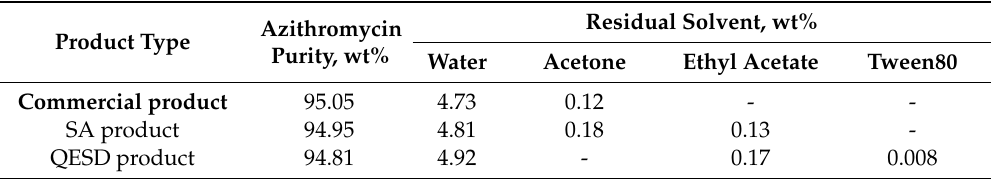
Table 3. Purity and residual solvent of spherical crystallization products.